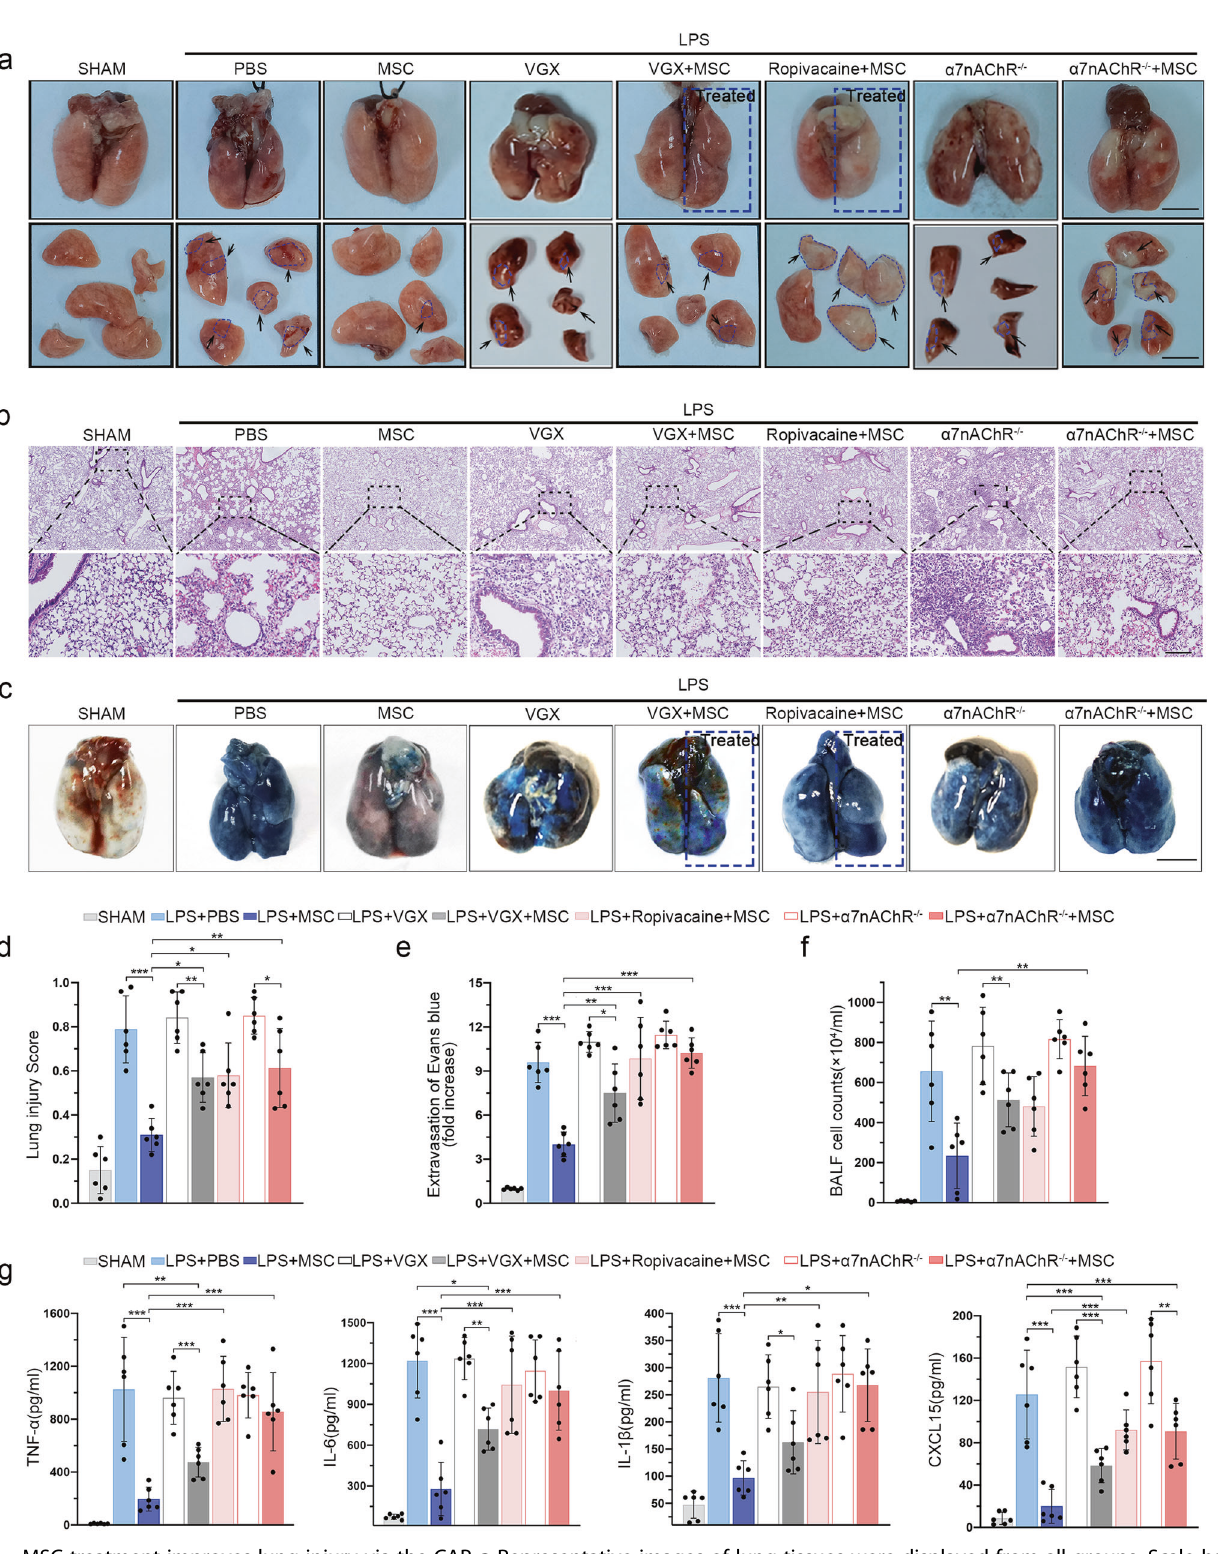
Fig. 1 MSC treatment improves lung injury via the CAP. a Representative images of lung tissues were displayed from all groups. Scale bars, 4 cm. b Representative H&E staining was performed on lung samples from each group. Photographs of at least 6 sections of each tissue sample were taken. Scale bars, 100 μ m. c Photographs showing Evans blue accumulation in lung tissues. d Quantitative analysis of the lung injury score; n = 6. e Evans blue extracted from lung tissues were quanti fi ed by spectrophotometric analysis; n = 6. f BALF total cell numbers were quanti fi ed; n = 6. g CXCL15, IL-1 β , TNF- α , IL-6 ELISA kits were used to determine BALF in fl ammatory concentrations; n = 6. * p < 0.05, ** p < 0.01, *** p <